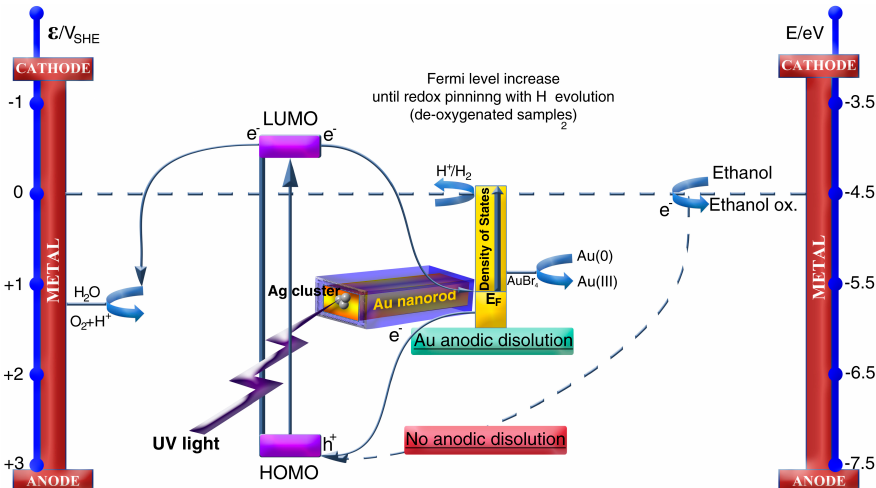
Figure 12. Schematic representation of the Au photodissolution and H 2 photoproduction by Ag clusters. The figure is form